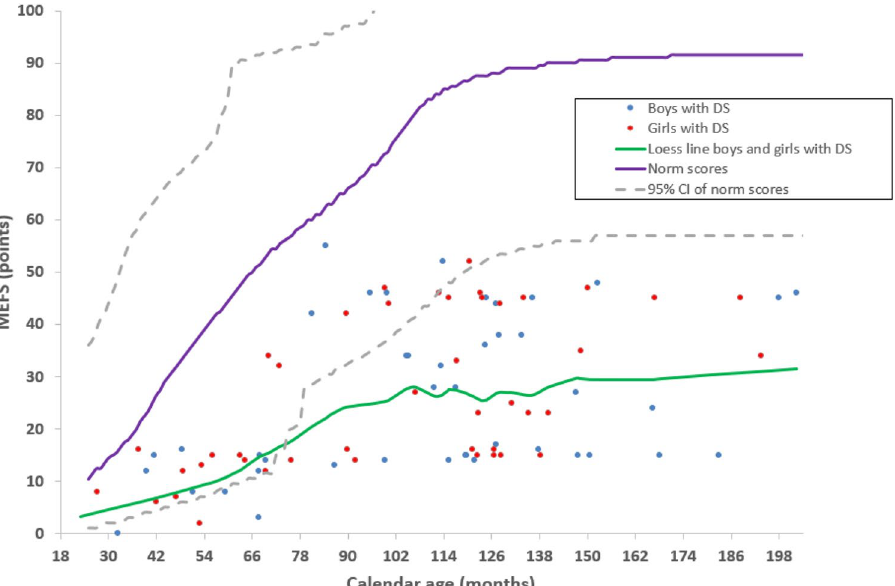
Figure 2. Task-based executive functions. Minnesota Executive Function Scale (MEFS) data of 86 children with DS as a function of calendar age together with normative data (n = 32,800, age range 24–216 months; Carlson 37 ). Note lower MEFS scores in children with DS compared to the norm scores. Blue bullets: Measured boys with DS (n = 43). Red bullets: Measured girls with DS (n = 43). Green curve: Loess line fitted to the data of the children with DS pooled across boys and girls. Purple curve: Norm scores (mean) of typically developing children pooled across boys and girls. Grey dashed lines: upper and lower bound of the 95% confidence interval of norm scores of typically developing